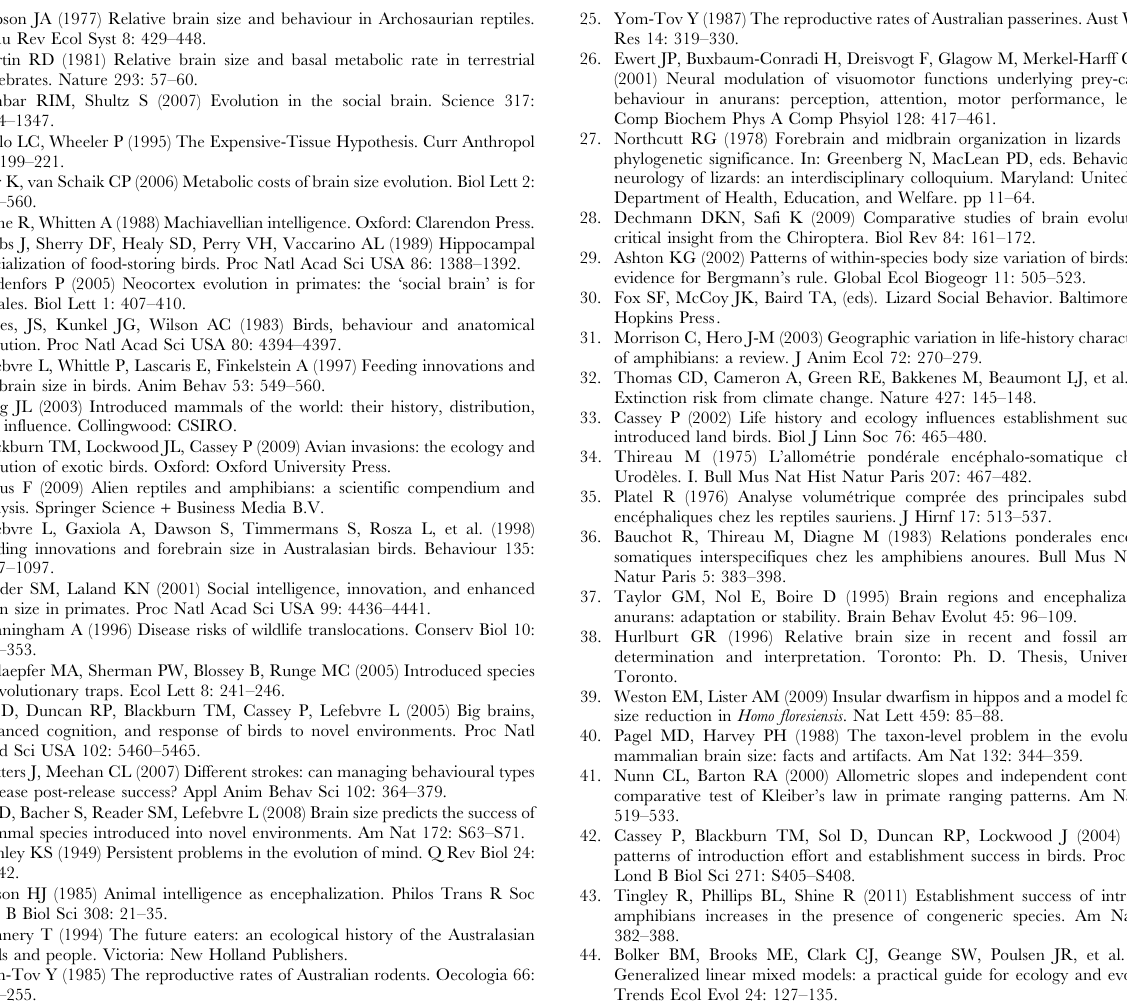
(TIF) Figure S2 Log brain mass versus log body mass for all amphibian and reptile species used in this study. The brain mass versus body mass trend inclusive of all biogeographic realms is shown in the top left panel, followed by the trends for each individual biogeographic realm.